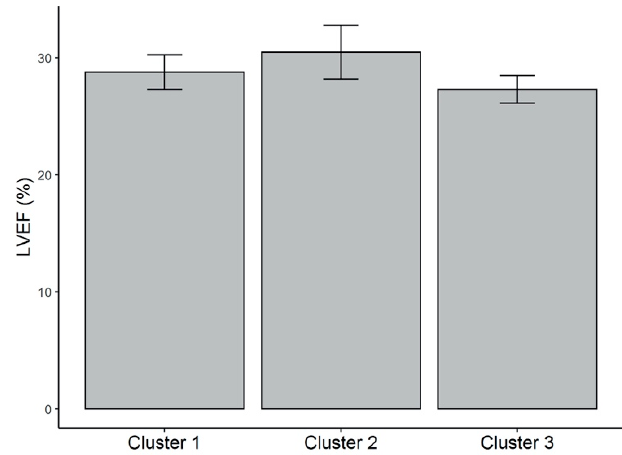
Figure A1. LVEF (%) values for each of the clusters. Mean and standard error (vertical bars) are shown. There was no significant difference of this parameter among clusters. LVEF = left ventricular ejection fraction.